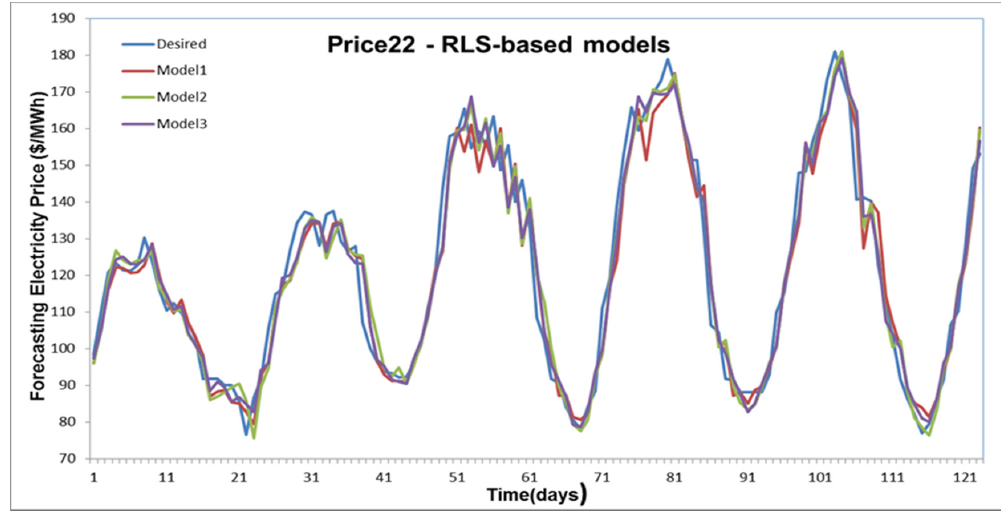
Figure 13. Performance of RLS-based models for electricity price at 22:00.